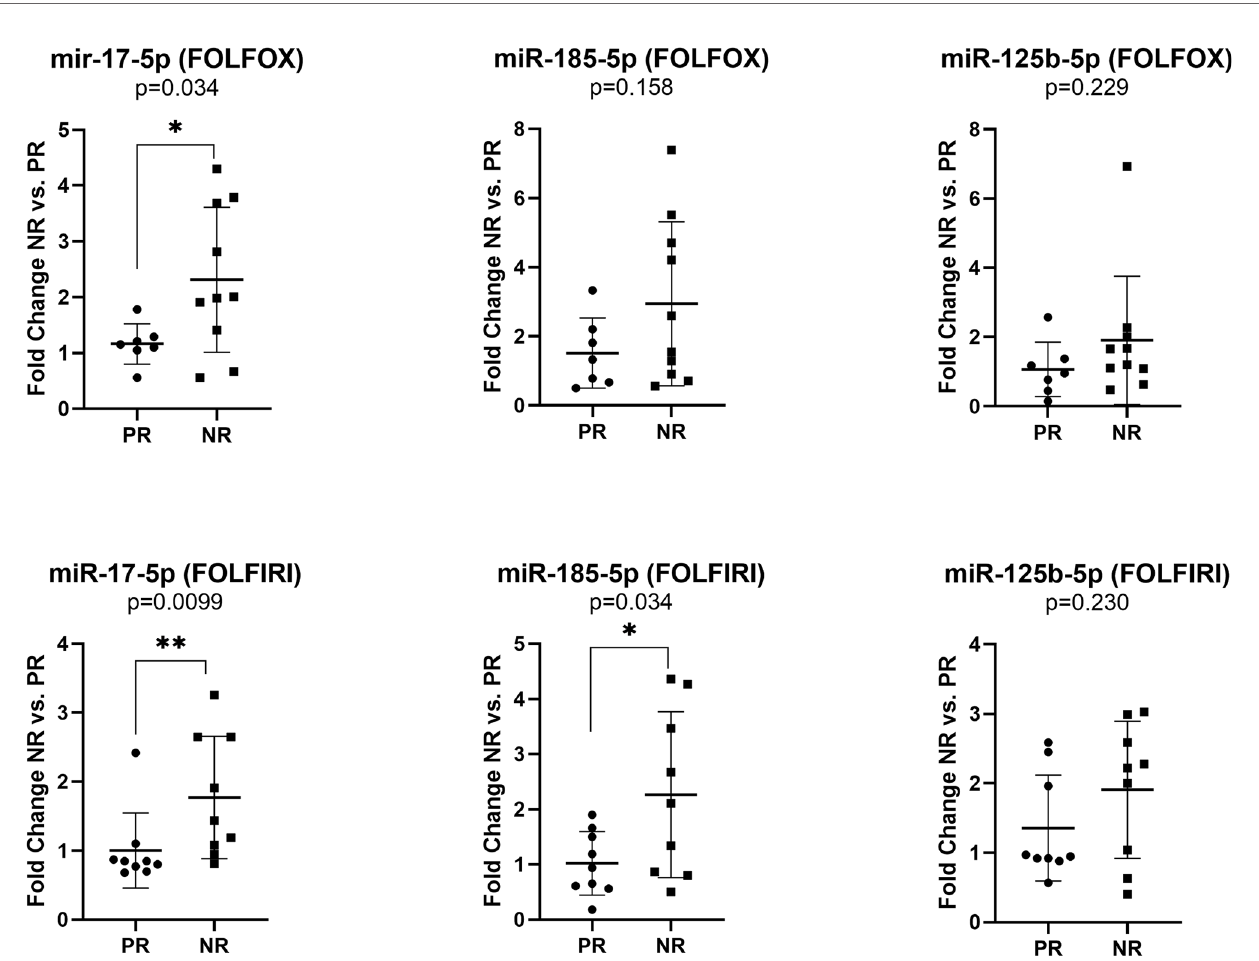
FIGURE 4 | Expression of miR-17-5p, miR-185-5p, and miR-125b-5p in the plasma exosomes of non-responders versus responder colorectal cancer patients for FOLFOX4 (n=10/7) and FOLFIRI (n=9/9) therapy. According to data distribution, differential expression was tested using the non-parametric Mann-Whitney U test (miR-17-5p and miR-125b-5p) or parametric unpaired t-test (miR-185-5p). Fold change for each sample was calculated relative to PR group *p ≤ 0.05; **p ≤ 0.01.